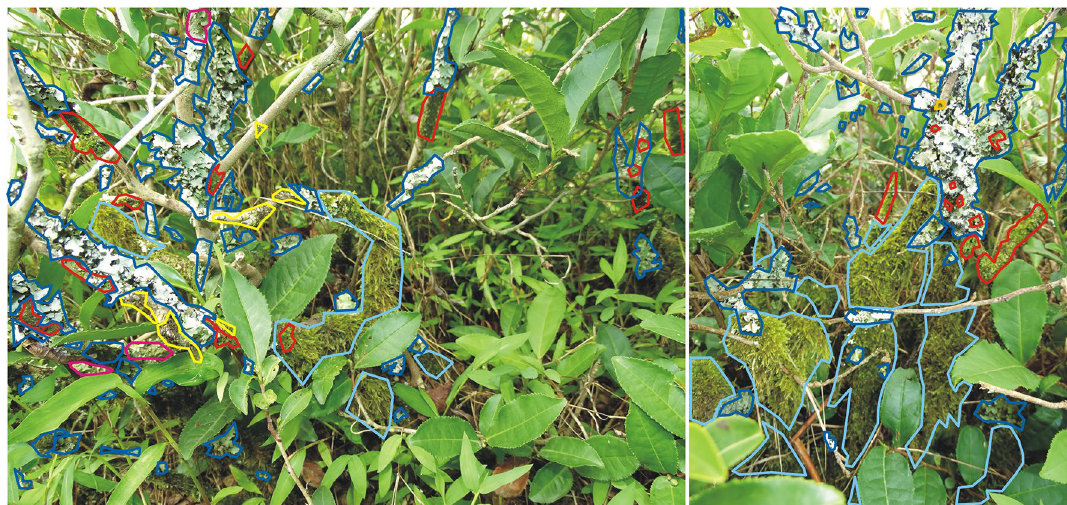
Figure 6. Distribution patterns of lichens and bryophytes of the Kobuleti plantation (photos by R. Piwowarczyk, 29 July 2018). Explanation: Flavoparmelia caperata —dark pink, Hypnum cupressiforme —blue, Metzgeria furcate —yellow, Orthotrichum sp.—orange, Parmotrema perlatum —dark blue, Radula complanata —